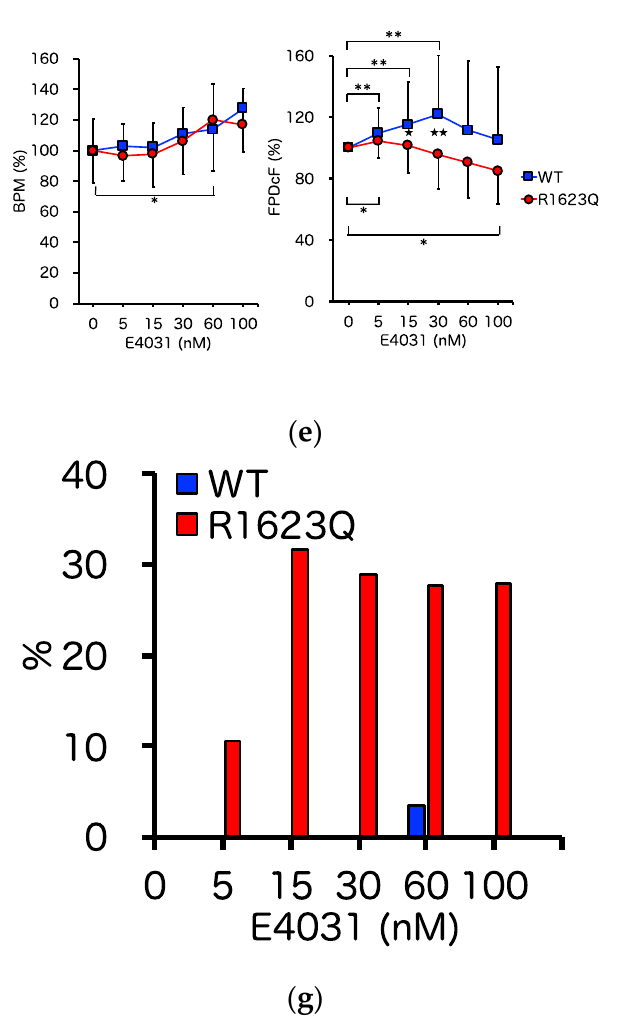
Figure 4. Electrophysiological analysis of induced pluripotent stem cell (iPSC) derived cardiomyocytes (CMs). ( a ) Representative baseline field potential waveforms in iPSC-CMs from healthy volunteers (upper) and patients with R1623Q mutation (lower). ( b ) The FPDcF of WT iPSC-CMs was significantly different from that of R1623Q mutation-harboring iPSC-CMs (WT, n = 22; R1623Q, n = 70, **** p < 0.0001). ( c ) Representative traces showing the Na + spike overlaid at the baseline and increasing concentration of mexiletine. The bar graph presents the mean ± standard deviation (SD) percentage change in total spike amplitude at increasing mexiletine concentrations (WT, n = 7; R1623Q, n = 6). * p < 0.05, ** p < 0.01, baseline vs. each dose. There were no significant differences in percent changes between WT and R1623Q at each dose level. Dose–response plots showing the effects of mexiletine (WT, n = 10; R1623Q, n = 7) ( d ) and E4031 (WT, n = 33; R1623Q, n = 28) ( e ) on BPM and FPDcF. All data were normalized to the baseline value. Values are represented as mean ± SD. * p < 0.05, ** p < 0.01, *** p < 0.001, Baseline vs. each dose. ★ p < 0.05, ★★ p < 0.01 WT vs. R1623Q. ( f ) Screenshots of representative raw tracings showing early afterdepolarization (EAD) and triggered activity (TA). ( g ) The incidence of EAD events after E4031 administration in MED analysis (WT, n = 34; R1623Q, n = 38).